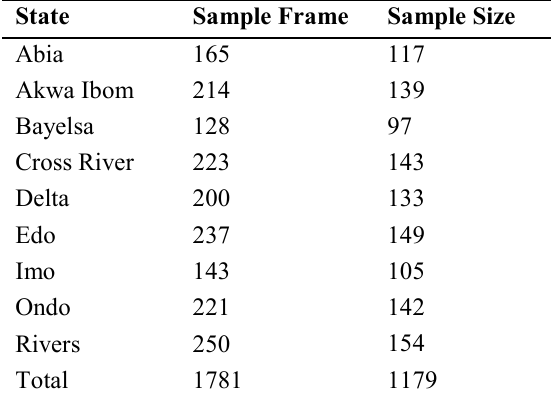
Table 1. Sample Frame and Sample Size of Construction Firms in Niger Delta (developed by the authors) (Otali et al. ,